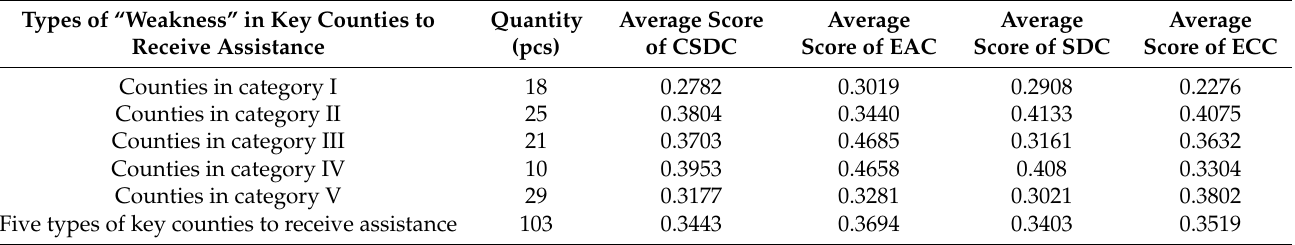
Table 4. The classification of “weakness” restriction types and the average value for each ability of key counties to receive